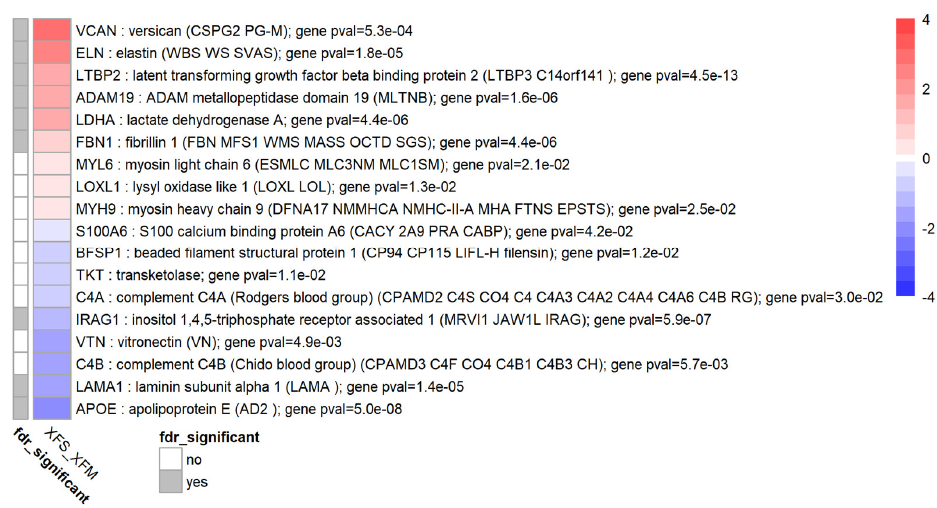
Figure 4. Differential expression of exfoliation material (XFM) genes. Heatmap showing the genes with per-gene p -value, where p < 0.05, for XFM genes. Heatmap colours correspond to fold change expressed as log 2 FC which has been limited to a range of [-4, 4] for clarity. The grey annotation bar on the left shows if the genome-wide false discovery rate has an FDR < 0.05 (in which FDR is the Benjamini-Hochberg corrected p -value) for a particular gene. A total of 9 XFM genes were upregulated and 9 XFM genes were downregulated in response to TGF-β1.